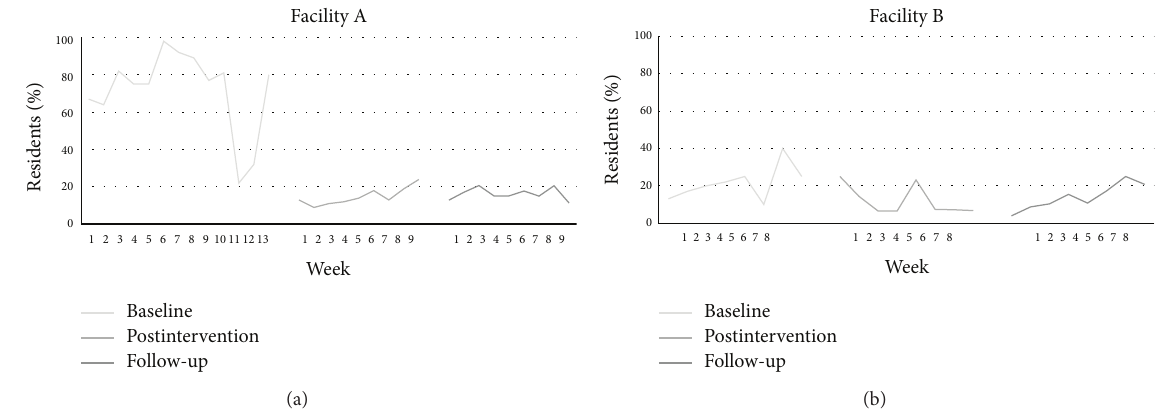
Figure 3: Percentage of residents who were found to have moderate-to-severe pain following the standardized weekly assessments. Note . For Facility A, the percentages are based on a total number of residents ranging from 𝑁 = 8–50 prior to the intervention and 𝑁 = 88–116 after the intervention and at follow-up (the denominator varied from week to week). For Facility B, the percentages are based on a total number of residents ranging from 𝑁 = 4–16 prior to the intervention and 𝑁 = 24–31 after the intervention and at follow-up (the denominator varied from week to week).